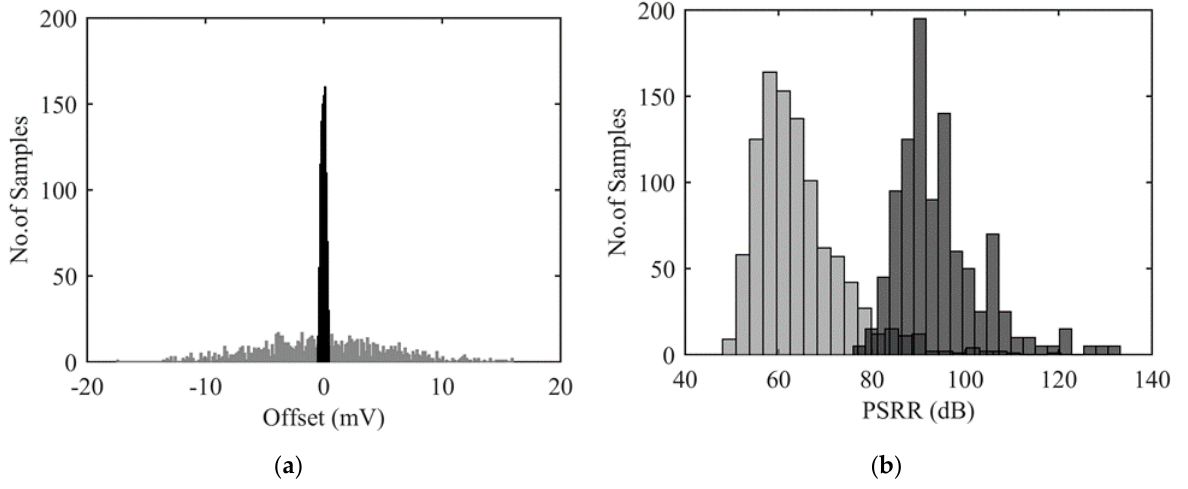
Figure 9. Monte Carlo simulations: Offset ( a ) and PSRR ( b ) are reported for a WB before (in grey) and after (in black) offset compensation. and after (in black) offset